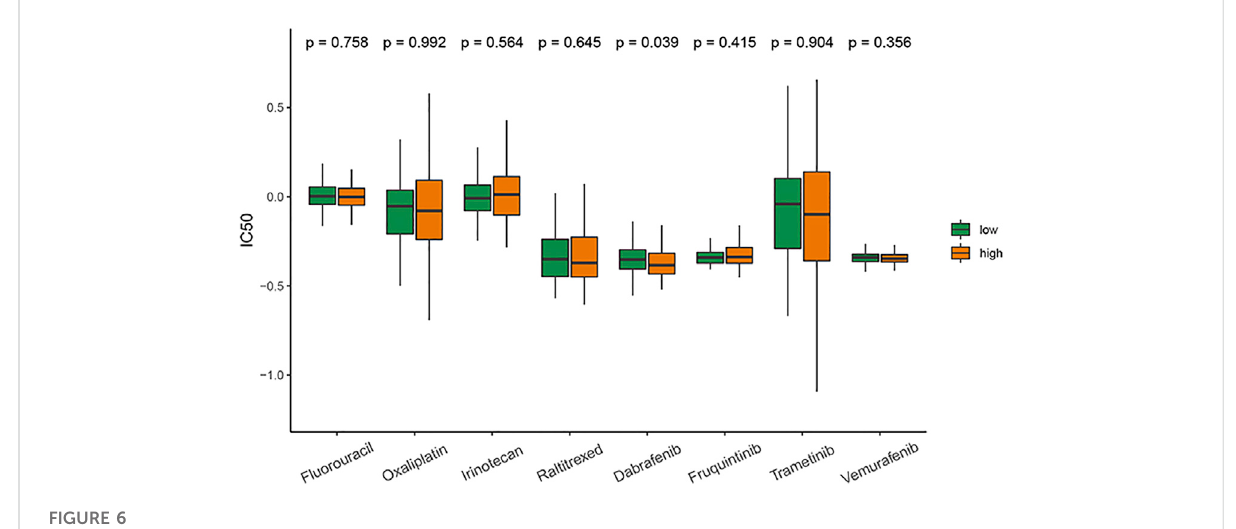
FIGURE 6 Comparison of drug sensitivity between the high- and low-risk